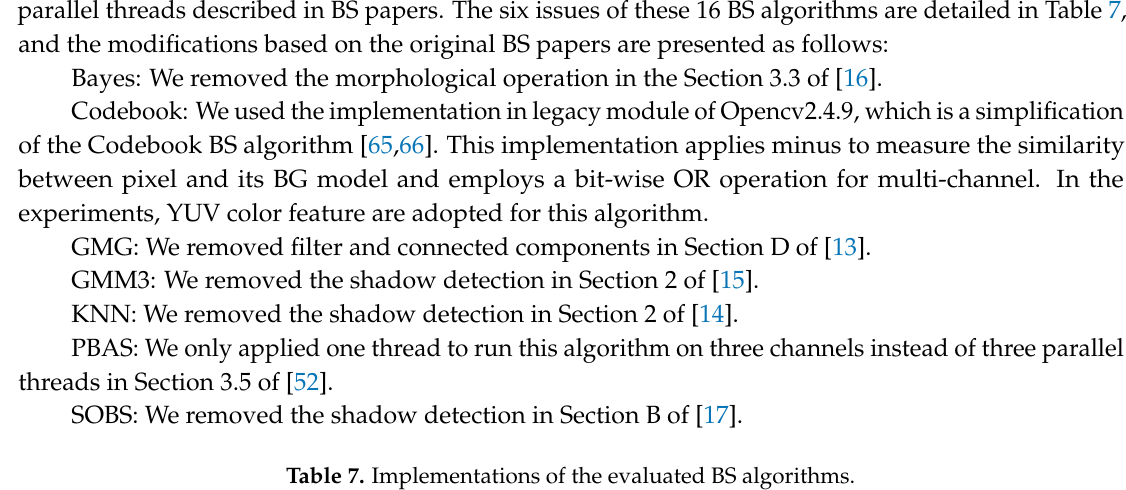
Table 7. Implementations of the evaluated BS